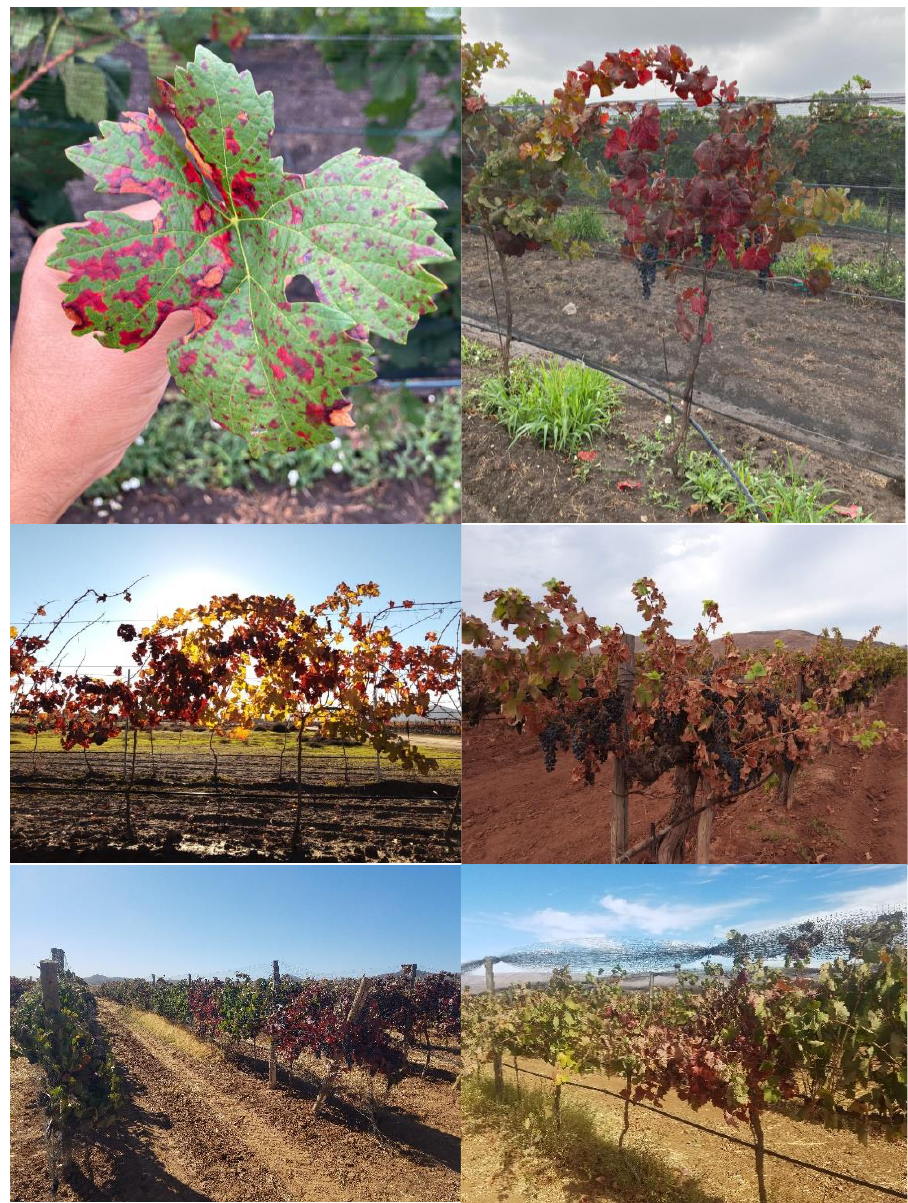
Figure 2. Virus-like symptoms observed in commercial vineyards located in Mexico. Symptoms include red and chlorotic spots on leaves, leaf deformation, vein necrosis and reduction in shoot growth.